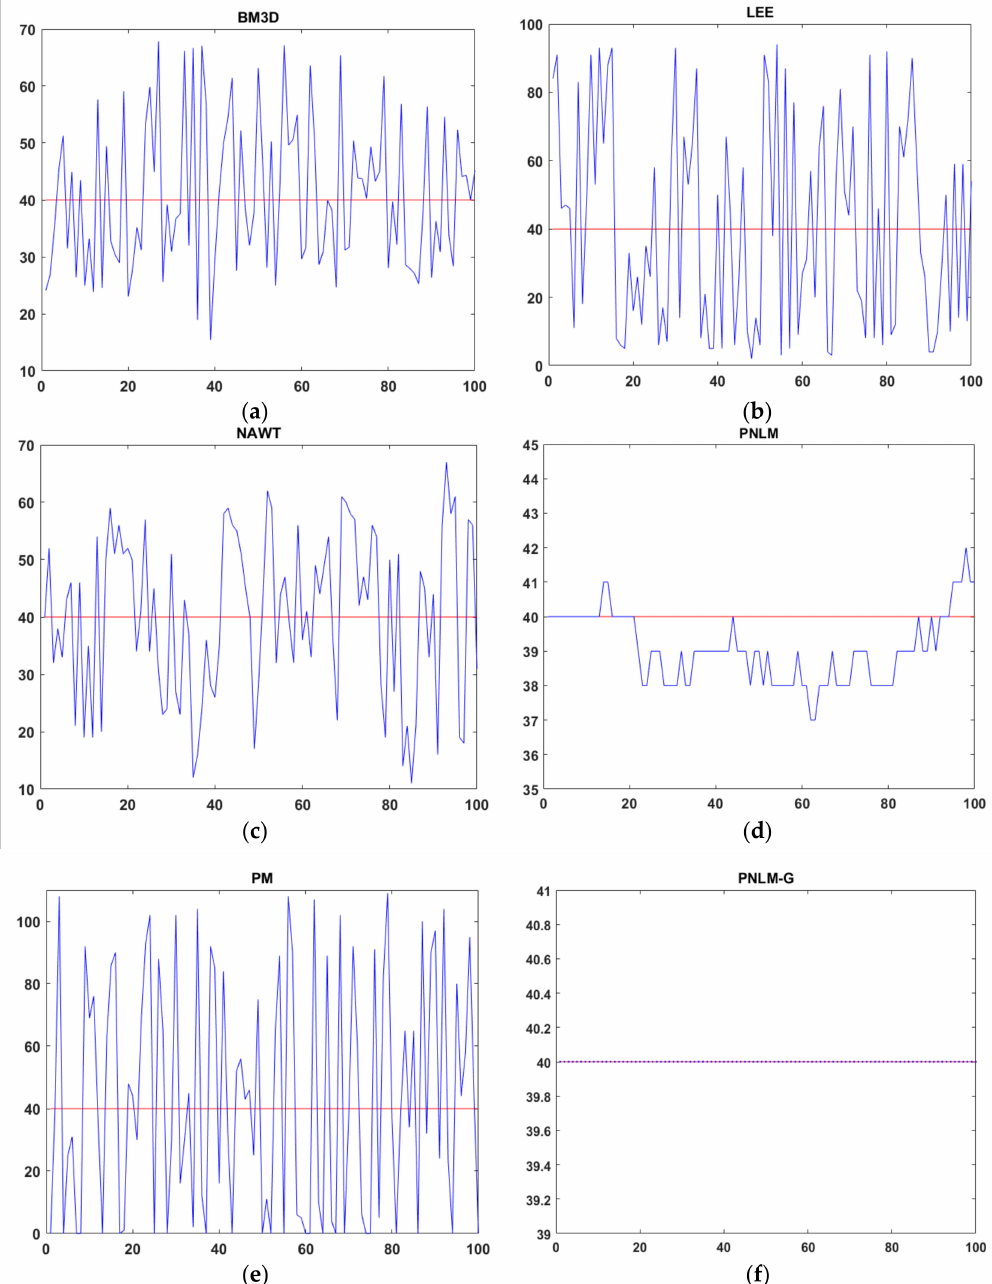
Figure 7. ( a ) Gray recovery of BM3D; ( b ) gray recovery of LEE; ( c ) gray recovery of NAWT; ( d ) gray recovery of PNLM; ( e ) gray recovery of PM; ( f ) gray recovery of